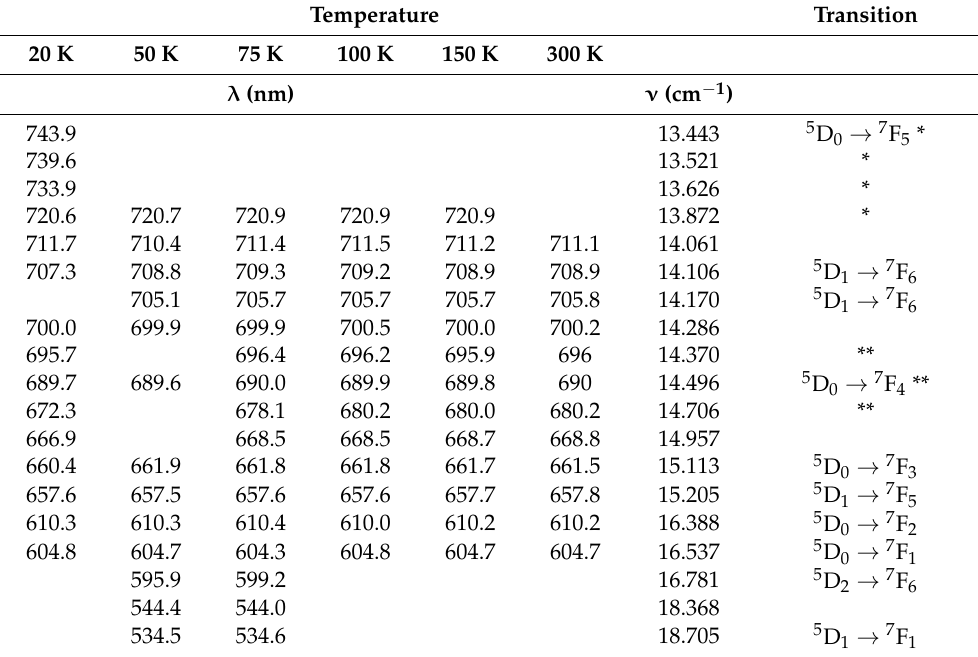
Table 5. Photoluminescence spectra and transition assignment for the ZnSe:Eu 3+/ Yb 3+ semiconductor. *, ** cubic crystal field